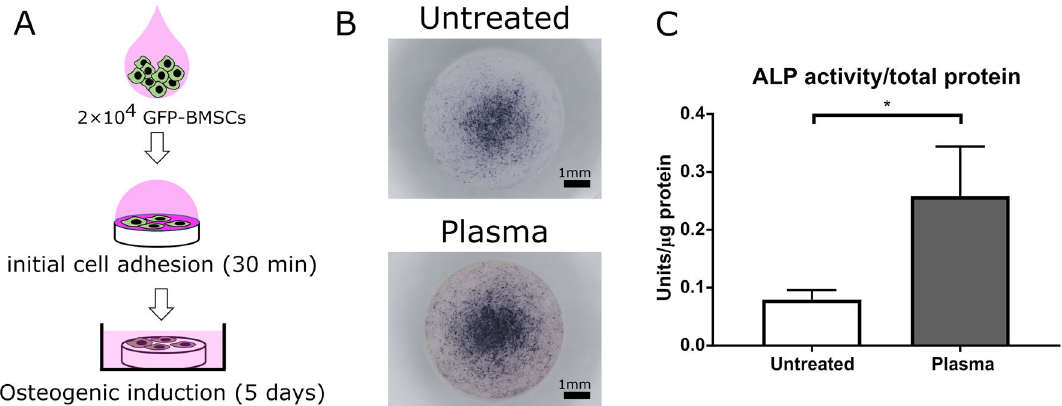
Figure 5. Osteogenic differentiation assay for rat BMSCs on untreated and plasma-treated β-TCP disks. ( A ) Schematic diagram of the osteogenic differentiation assay (drawn by using Microsoft PowerPoint 2016). ( B ) Macro photos of ALP-stained rat BMSCs sub-cultured on untreated (top) and plasma-treated (bottom) dense β-TCP disks. The black in the image represents the ALP stain. ( C ) The ALP activity values, as defined in the section Materials and methods, for untreated and plasma-treated β-TCP disks. The data here are expressed as mean ± SD (n = 3). * p < 0.05.